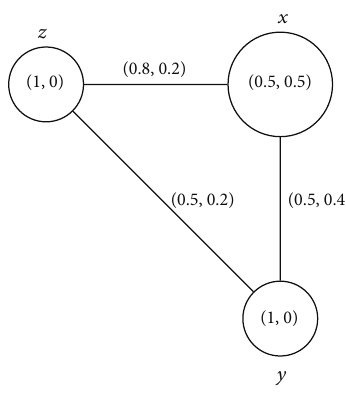
Figure 5: Connected intuitionistic fuzzy graph.